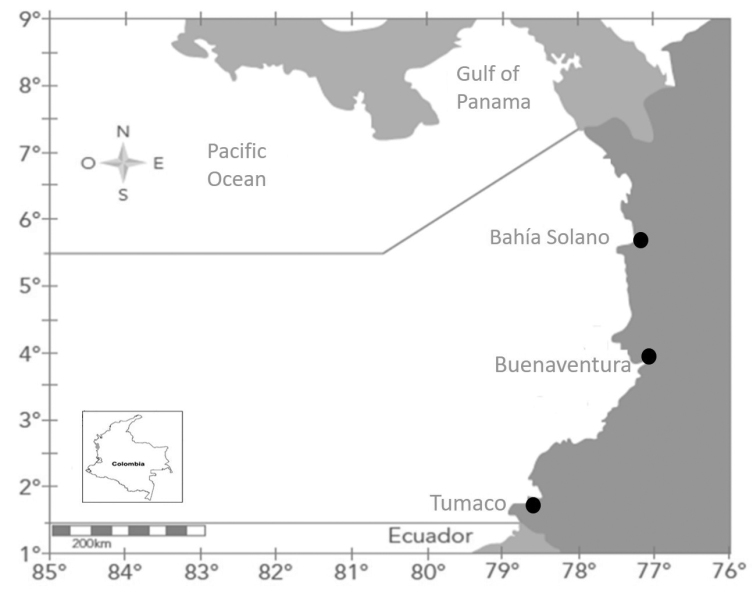
Sampling locations (modified from Dorado Roncancio 2018).